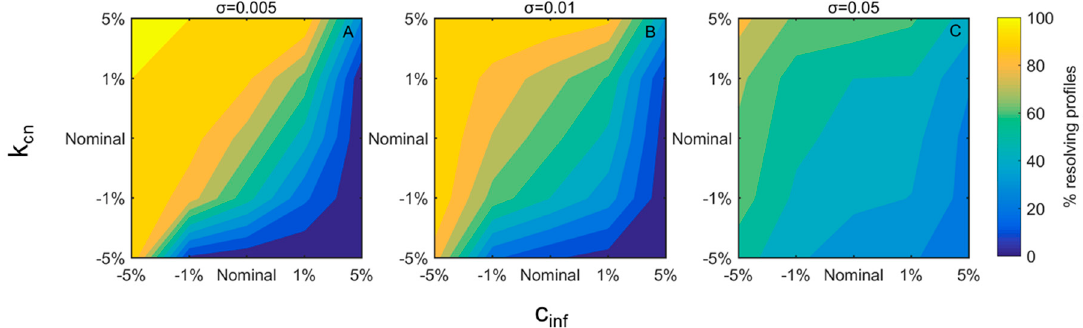
Figure 6. Percent resolving profiles for different values of k cn and c inf at three noise levels ( A – C ). Parameters were varied by ± 1% or ± 5% of their nominal values shown in x- and y-axes. From blue to yellow the % resolving profiles are increasing. Different subplots represent different noise levels ( σ ).